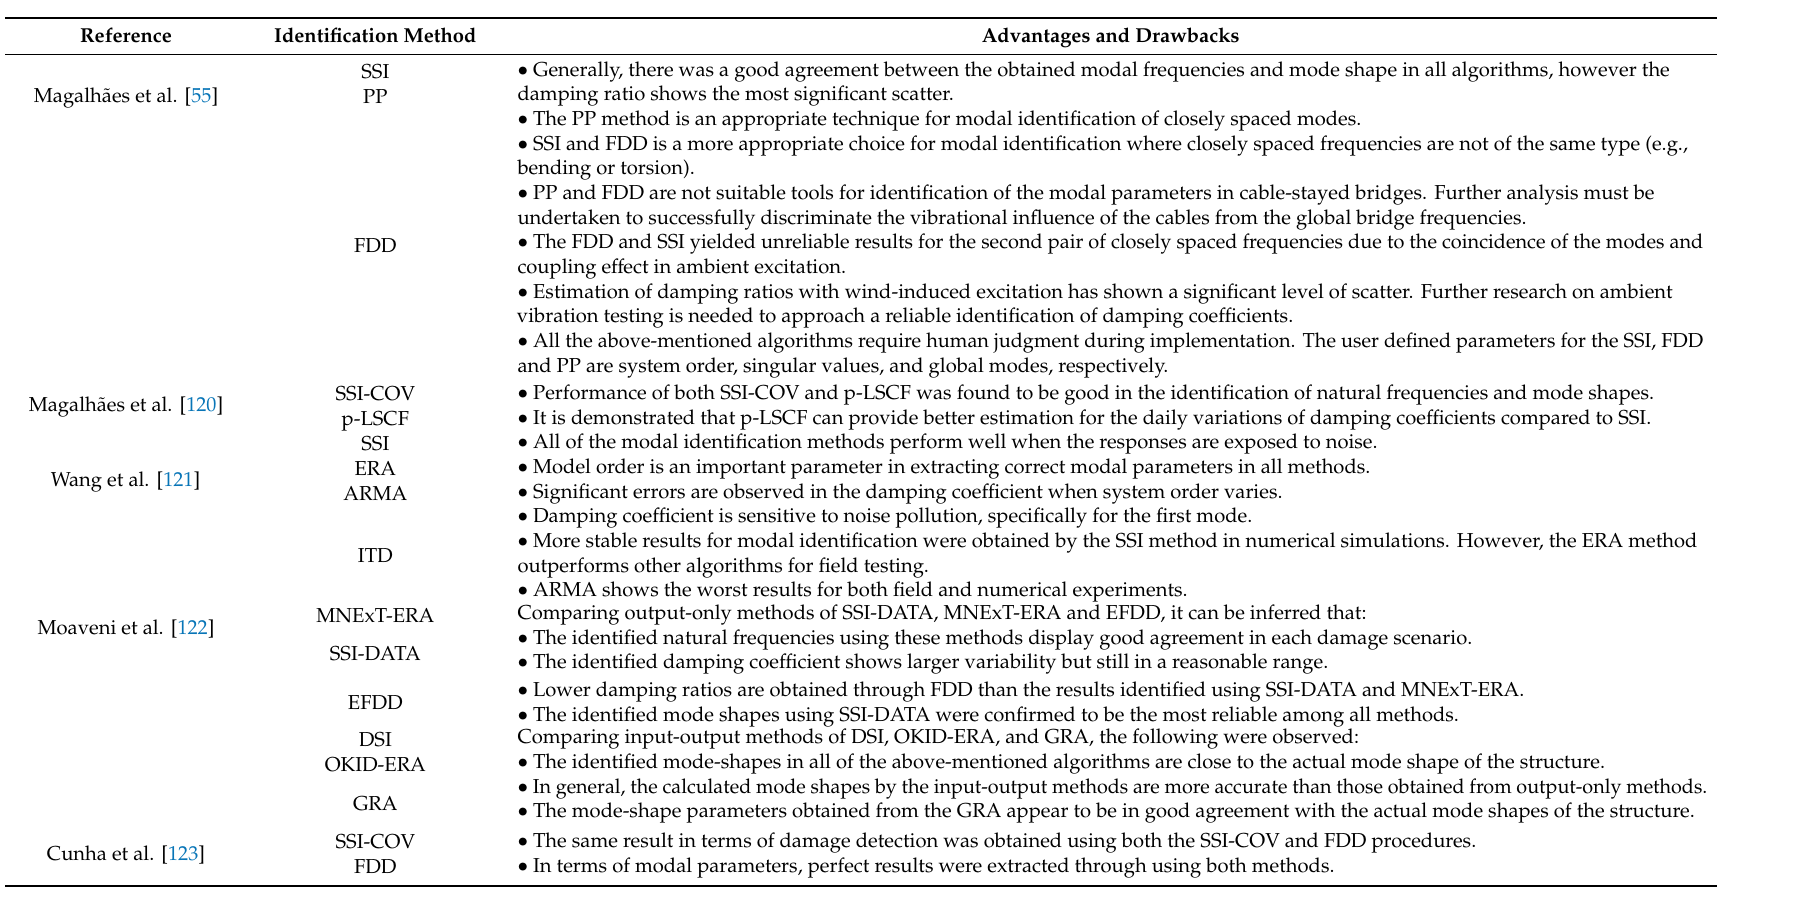
Table 5. Comparison between subspace system identification (SSI) method and other system identification